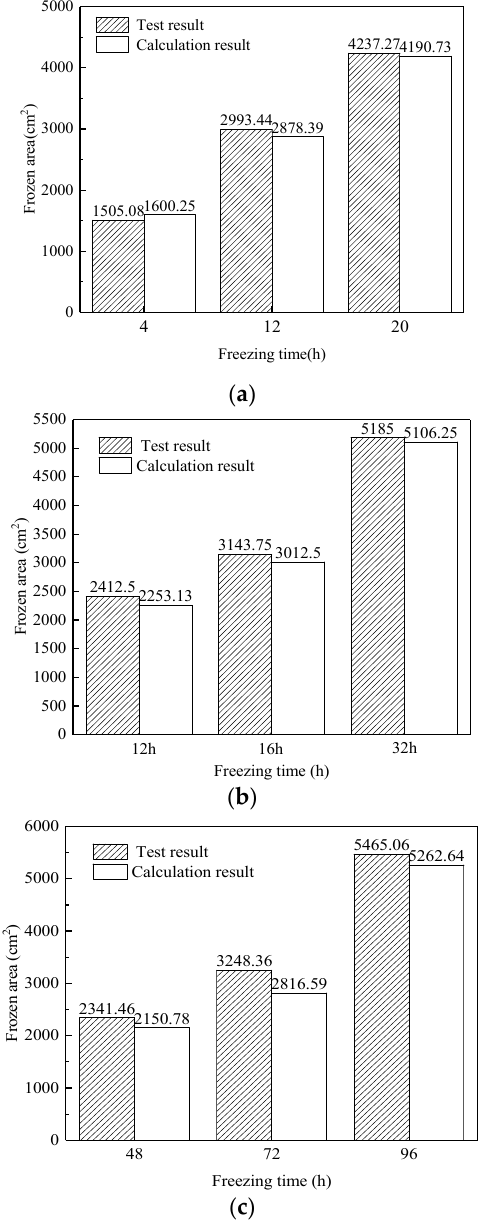
Figure 9. Comparison between simulated and measured results of frozen area under different seepage velocities. ( a ) 0 m/d; ( b ) 3 m/d; ( c ) 9 m/d. According to the comparison of temperature change curve and freezing front, it could be seen that the numerical calculation model constructed in this paper could realize the prediction and calculation of artificial freezing temperature fields under the action of groundwater. 4. Optimized Design of Freezing Holes under the Action of Groundwater with Different Flow Rates According to the maldevelopment mechanism of frozen walls induced by groundwater, the layout method of freezing holes of permeable stratum with high